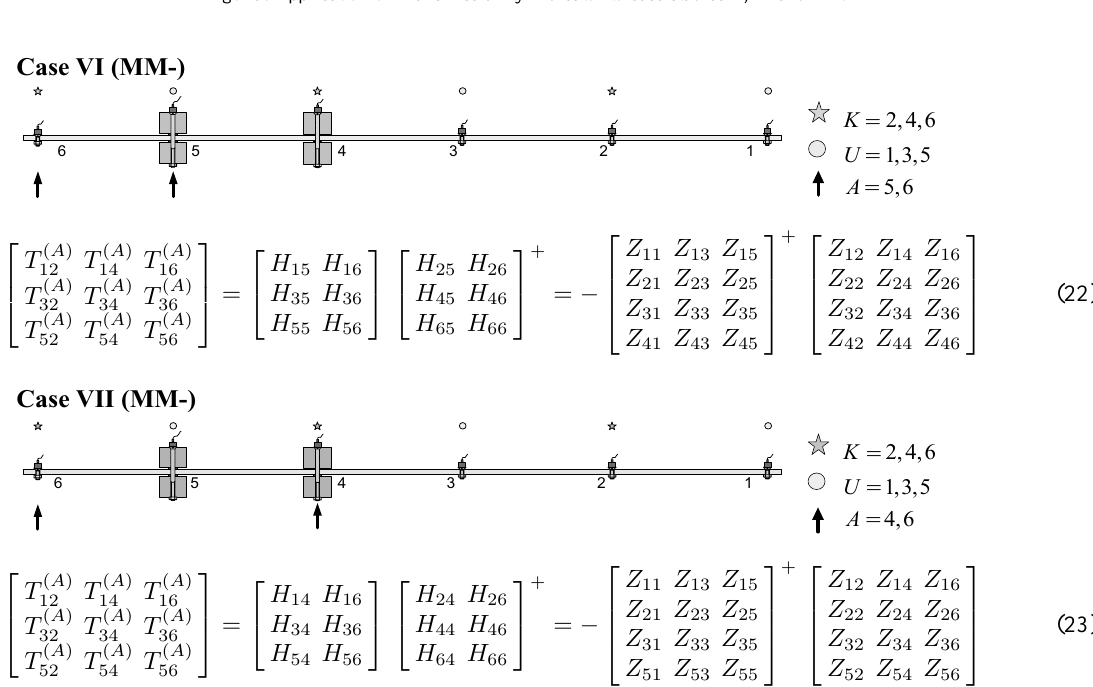
Fig. 18. Application of Transmissibility Indicator to case studies V, VI and